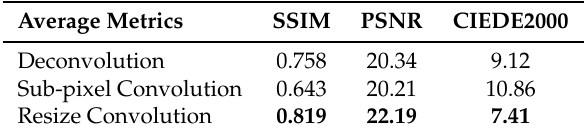
Figure 13. Effectiveness of the proposed network with resize convolution. ( a , e ) Input hazy images. ( b , f ) Dehazed images using deconvolution. ( c , g ) The dehazed images using sub-pixel convolution. ( d , h ) Denote dehazed results using resize convolution (ours). ( e – h ) The zoom-in views of ( a – d ), separately. Table 6. Average scores in terms of PSNR, SSIM, and CIEDE2000 for deconvolution, sub-pixel convolution, and resize convolution on the synthetic test set from HazyWater